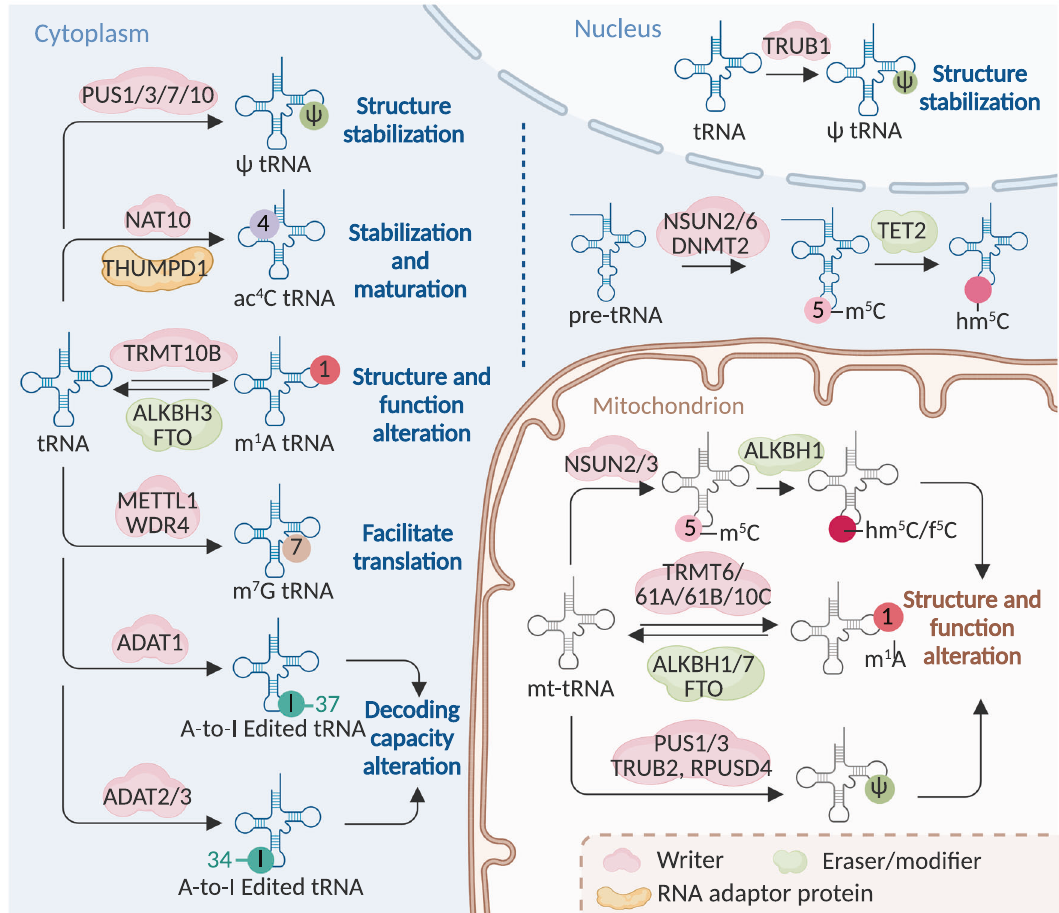
Fig. 5 The machinery of RNA modi fi cations and their molecular functions in tRNA. The indicated RNA modi fi cations are installed on tRNA through indicated writers, and m 1 A modi fi cations can be removed by ALKBH3 and FTO, while m 5 C modi fi cation on pre-tRNA can be converted into hm 5 C or f 5 C by TET2. These modi fi cations on tRNA can alter the structure of tRNA, thereby regulating its functions to affect the translation ef fi ciency. The same modi fi cation can be installed by different writers on tRNAs in different parts of the cell. A-to-I editing on different tRNA positions can be added by different writers. ac 4 C writer NAT10 modi fi es tRNAs assisted by the adaptor Tan1/THUMPD1. m 5 C 5- methylcytosine, m 1 A N 1 -methyladenosine, m 7 G 7-methylguanosine, ac 4 C N 4 -acetylcytidine, ψ pseudouridine, A-to-I adenosine-to-inosine, hm 5 C 5-hydroxymethylcytidine, f 5 C